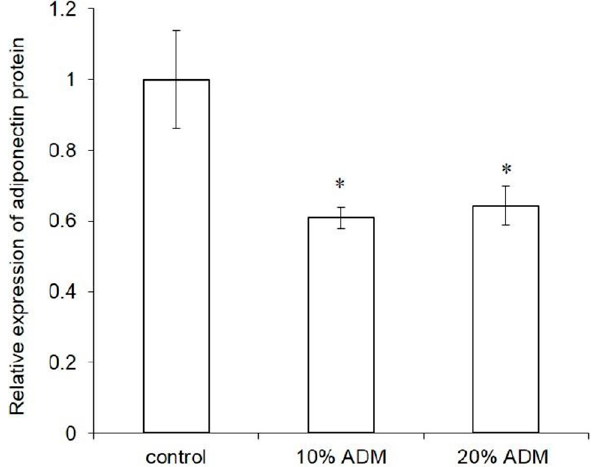
Figure A1. Adiponectin expression in Hs68 fibroblasts with or without ADM treatment. Hs68 fibroblasts were incubated for 7 days with or without ADM treatment (10% or 20%). A comparison of adiponectin protein content were determined by ELISA and expresses as relative adiponectin quantity. Data are expressed by the mean intensity of adiponectin expression compared to control ± standard deviation, n = 3. * p = 0.05.